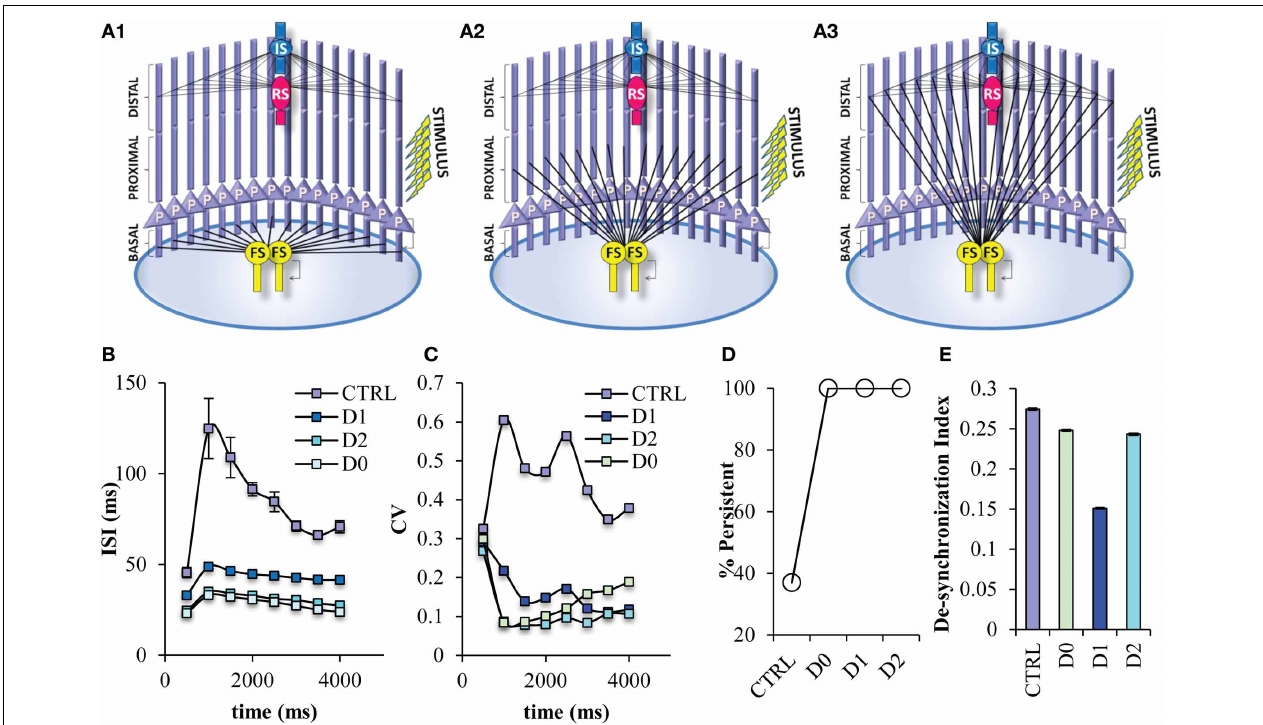
FIGURE 8 | Persistent activity properties when the FS interneuron model projects to different dendritic compartments. Different variations of the PFC microcircuit were constructed in order to study the effect of the projection site of FS model neurons onto the pyramidal neurons. (A) Graphical representations of the FS interneuron model projecting to the basal (D0) (A1) , the proximal (D1) (A2) , and distal (D2) (A3) dendritic compartment of the pyramidal neuron model. (B) Graph showing ISIs before and during persistent in 500ms bins for the control and the different projecting site networks. The ISIs of pyramidal neuron models are decreased in all